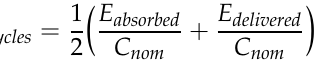
Table 5. Input data for the economic analysis.